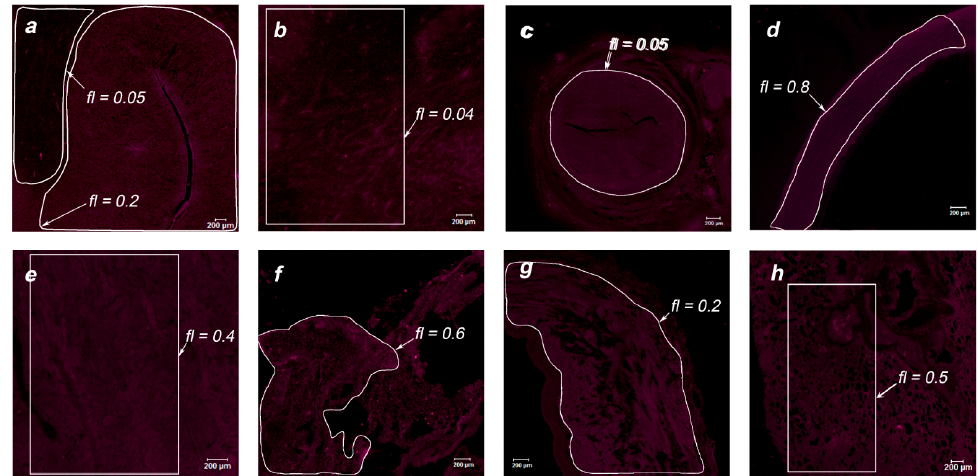
Figure 9. Images of organs of Primate A (3 h after MB administration) obtained using laser scanning confocal microscopy: ( a ) white and gray matter; ( b ) cerebellum; ( c ) ureter; ( d ) aorta; ( e ) kidney; ( f ) pancreas; ( g ) heart; ( h ) lungs. Areas of interest are highlighted in white, according to the accumu- lated MB. The index corresponds to the level of MB in this area of mg/kg.